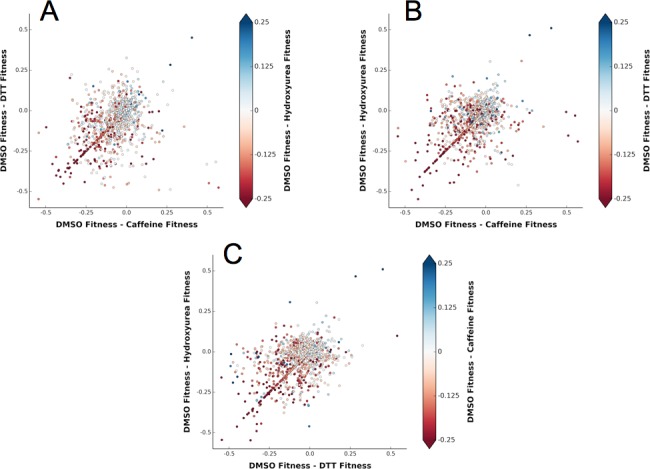
A shared response to different chemical perturbations.(A) DMSO fitness - Caffeine fitness vs. DMSO fitness - DTT fitness. The markers are colored based on DMSO fitness - Hydroxyurea fitness. (B) DMSO fitness - Caffeine fitness vs. DMSO fitness - Hydroxyurea fitness. The markers are colored based on DMSO fitness - DTT fitness. (C) DMSO fitness - DTT fitness vs. DMSO fitness - Hydroxyurea fitness. The markers are colored based on DMSO fitness - Caffeine fitness.DOI:
http://dx.doi.org/10.7554/eLife.15802.01610.7554/eLife.15802.017Figure 9—source data 1.Shared response mutants representing mutations that are equally perturbed by all three sensitizing perturbations.Mutants in the shared response were determined by fitting a line to the fitness scores. The distance from each point to that line was calculated. If the distance was less than 0.1 and the average Δ (DMSO - Perturbation) fitness was less than -0.2 the mutant was considered part of the shared response. E1 activity relative to WT Ub (Roscoe and Bolon, 2014) is listed and may explain the sensitization of some of the shared response mutants.DOI:
http://dx.doi.org/10.7554/eLife.15802.01710.7554/eLife.15802.018Figure 9—source data 2.Perturbation specific mutations represent alleles that are differentially affected by Caffeine, DTT and Hydroxyurea.Perturbation specific mutations were determined by fitting a line to the delta (DMSO - perturbation) fitness scores. The distance from each point to that line was calculated. If the distance was greater than 0.35 the mutant was classified as perturbation specific. Mutants with high experimental errors were deemed outliers and removed from this list.DOI:
http://dx.doi.org/10.7554/eLife.15802.01810.7554/eLife.15802.019Figure 9—source data 3.Specific information regarding highlighted mutants.